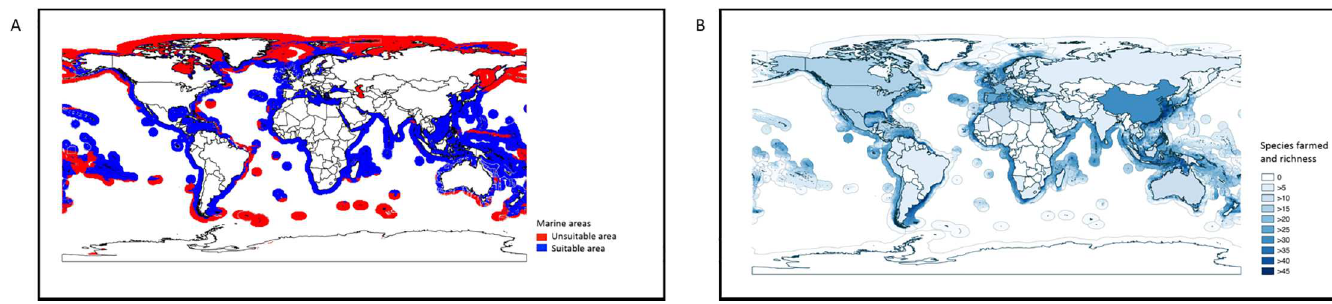
Fig 5. Potential marine area suitable for mariculture production and current versus potential farmed species richness. (A) Total predicted suitable marine areas for mariculture in blue and unsuitable marine areas in red based on an average of four different species distribution models; (B) Comparison between present numbers of species farmed in different countries with potential numbers of farmed species based on model outputs. https://doi.org/10.1371/journal.pone.0191086.g005 PLOS ONE | https://doi.org/10.1371/journal.pone.0191086 January 19,